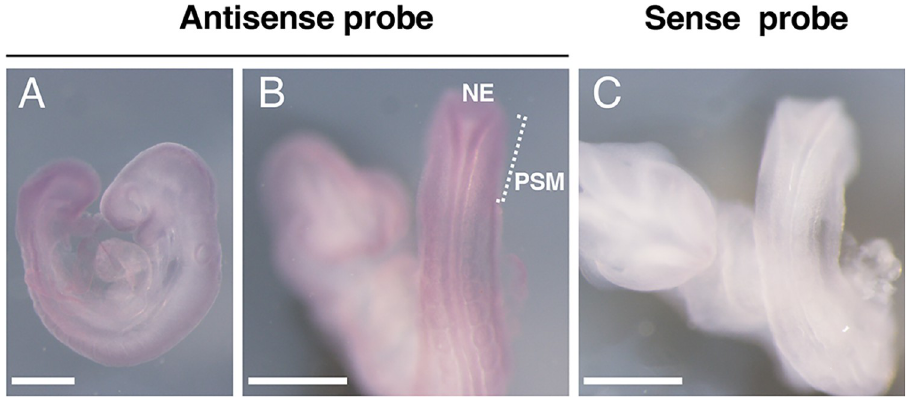
Fig 3. Slc35a3 mRNA was expressed in the presomitic mesoderm during somite formation. Whole-mount in situ hybridization images of wild-type mouse embryos at E9.25 (somite 20–22) produced using the antisense (A, B) and the sense (C) probes against Slc35a3 mRNA. Lateral side view (A), and the magnified images of the tail region (B, C). NE: neuroepithelium, PSM: presomatic mesoderm. Scale bars: 500 μ m. The same results were obtained from two independent